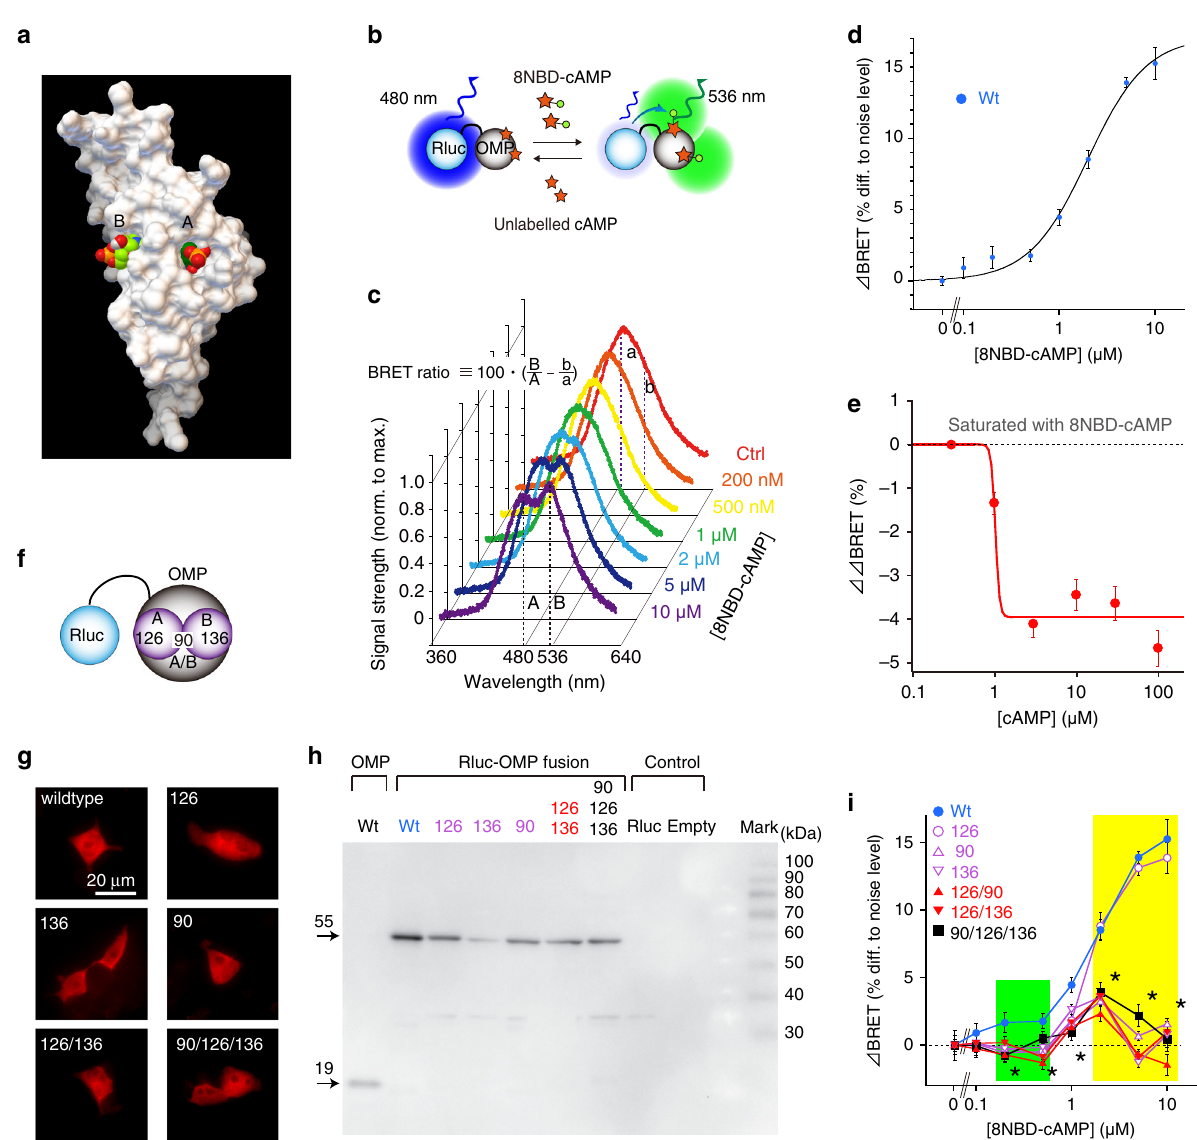
Fig. 2 BRET assay for assessing direct interactions between OMP and cAMP. a Computer-simulated docking conformation between cAMP and OMP. b Schematic diagram of BRET between Rluc-OMP and 8NBD-cAMP and a competitive assay in addition to unlabelled cAMP. c Representative BRET- emission spectra in the presence of different concentrations of 8NBD-c AMP. d Δ BRET for Rluc-OMP Wt . n = 8, 6, 25, 26, 23, 24 and 24 plates. e The decrease in Δ BRET ( ΔΔ BRET) for cAMP as a competitor. n = 3 plates. f Schematic localisation of mutated residues in Rluc-OMP. g Immunocytological con fi rmation of the cytosolic expression of the mutated Rluc-OMP fusion proteins. h Western blot con fi rmation of the sizes and concentrations of OMP and mutant Rluc-OMP fusion proteins. i Δ BRET for the various mutated Rluc-OMP proteins. Wt is the same as that shown in ( d ) for comparison. * P < 0.001. Experiments were repeated three times with similar results in ( g , h ). Statistics: ( i ) one-way ANOVA at different concentrations of 8NBD-cAMP with post hoc one-sided Dunnett ’ s multiple-comparison test for OMP WT ( n = 32) vs OMP Mut : 0 μ M, F (6, 96) = 0.0386, P ANOVA >0.99, P Dunnett >0.99 for all; 0.1 μ M, F (6, 97) = 3.048 , P = 0.00921, P 126 and OMP 126/136 and >0.1 for the others. In all, 0.2 μ M, F (6, 97) = 7.539, P ANOVA Dunnett < 0.01 for OMP P μ M, F (6, 105) = 16.05, P P = 0.0265 for OMP 90/126/136 and <0.01 for the others; 1 μ M, F (6, 98) = 72.17, Dunnett < 0.01 for all; 0.5 ANOVA < 0.001, Dunnett